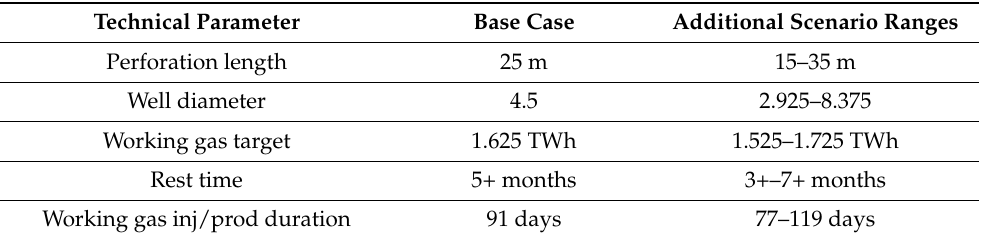
Table 2. Well parameters and schedule information for the base case and the sensitivity tests.